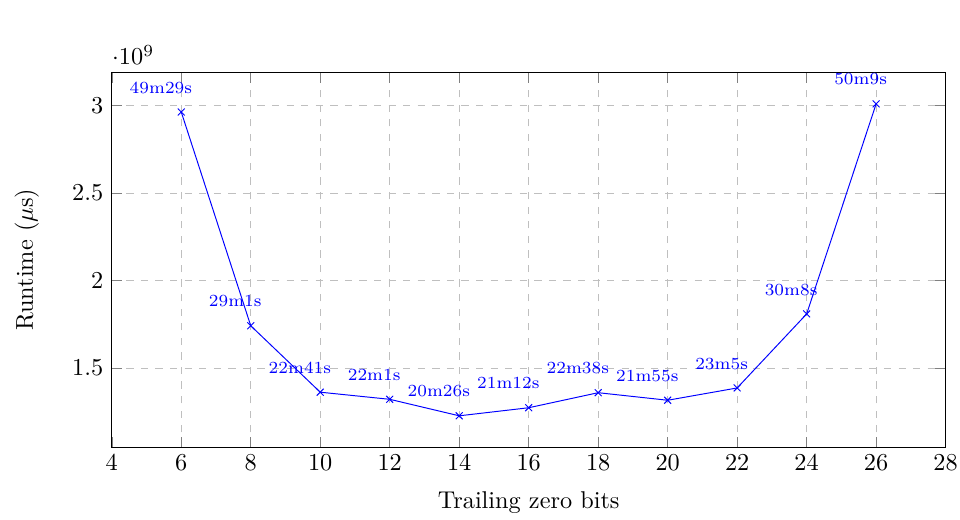
Figure 1: Timings of solving ECDLP for different values of θ , 65-bits curve, 28